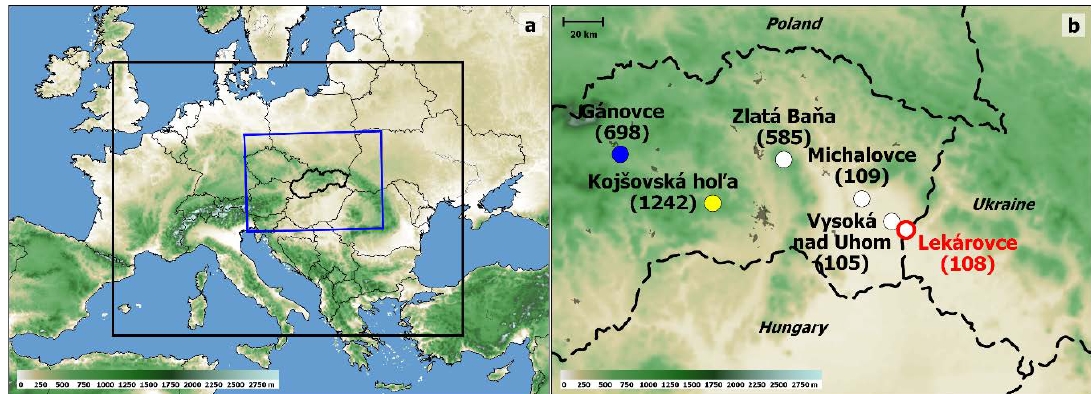
Figure 1. ( a ) Model domains in the study. OPM domain outlined by black rectangle, ELAM domain outlined by blue rectangle. Real topography shown as background. ( b ) Map zoomed on eastern Slovakia, showing locations discussed in the text. Country names shown in italics; tornado location highlighted in red. Other sites represent weather stations; altitude given in m a.s.l. in brackets. Blue circle: Gánovce sounding station; yellow circle: location of Kojšovská hoľa radar. Northeast of Michalovce is the Vihorlat mountain chain, south of the Vihorlat Mountains is Východoslovenská nížina lowland. Black areas : locations of larger towns in Slovakia.